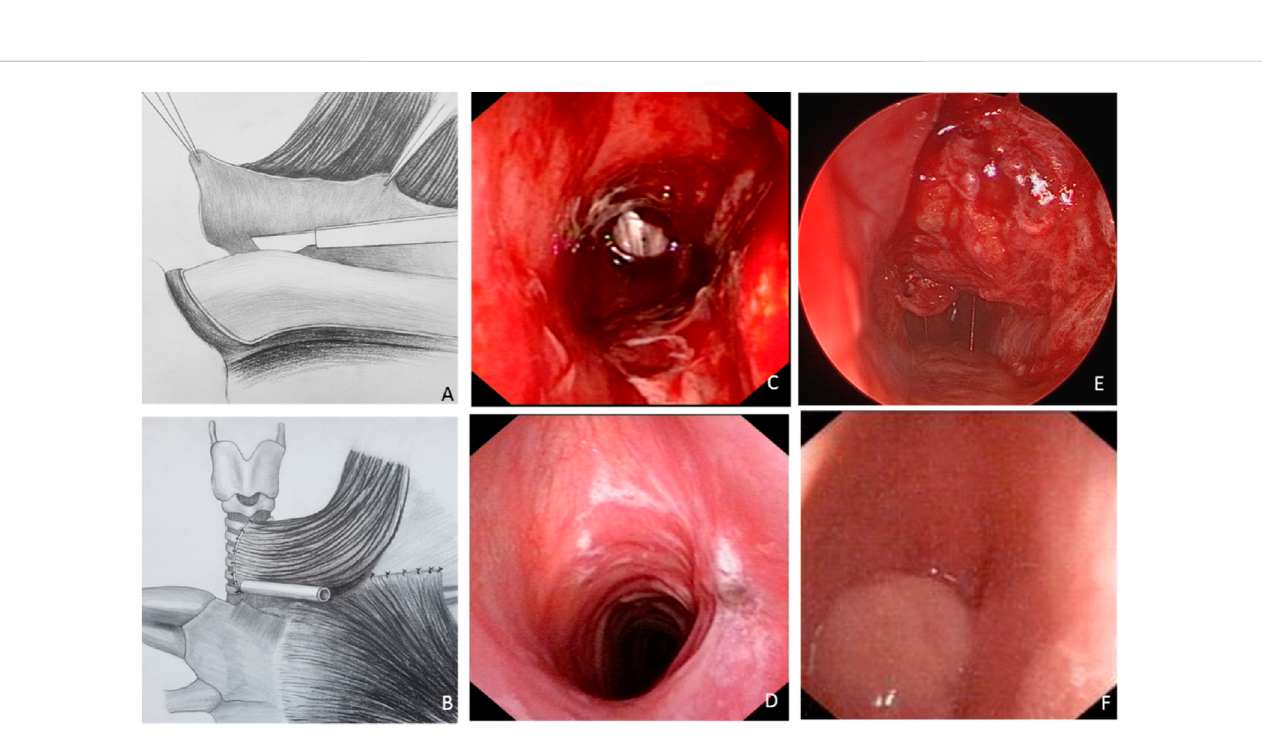
FIGURE 2 The tracheal reconstruction process via the sternocleidomastoid muscle (SCM) myoperiosteal fl ap and the laryngoscopic images of the two patients. (A,B) The clavicular periosteum was harvested and transposed to repair the tracheal defect. (C,D) Laryngoscopic images of patient one taken immediately (C) and 2-month (D) after surgery. (E,F) Laryngoscopic images of patient two taken immediately (E) and 2-month (F) after